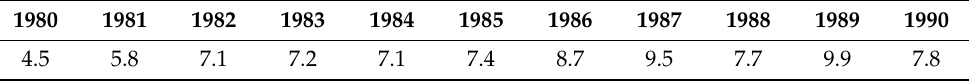
Table 2. Number of carcinoses per 1000 inhabitants and year in Kharakalpakstan, Uzbekistan.